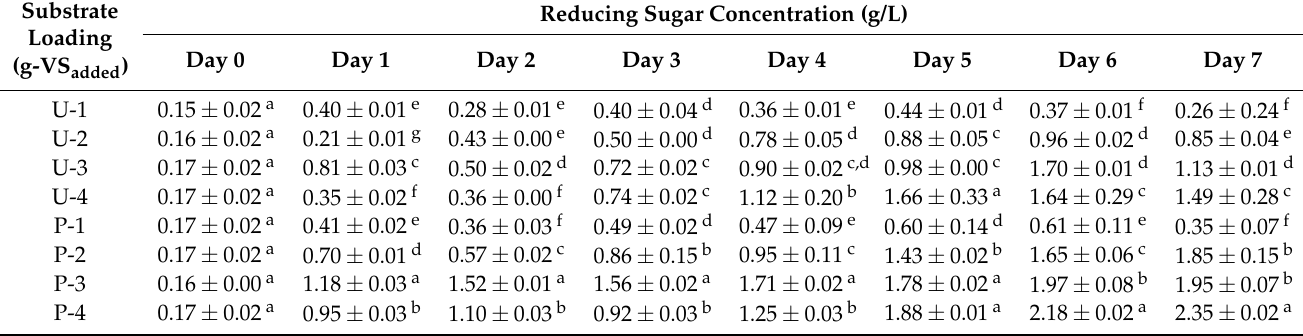
Table 4. The effects of substrate loading on the enzymatic hydrolysis of untreated and DES pretreated sugarcane leaves by the cellulolytic consortium.